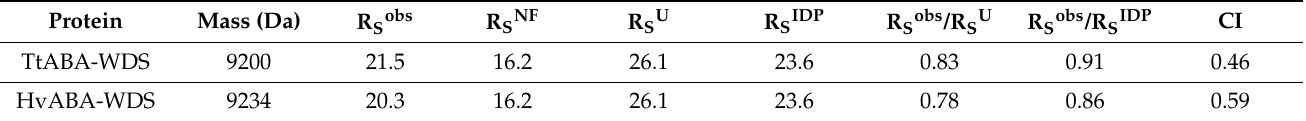
Table 2. Stokes radii (R Sobs , Å) as obtained by SEC and expected values for the various conformational states. Protein Mass